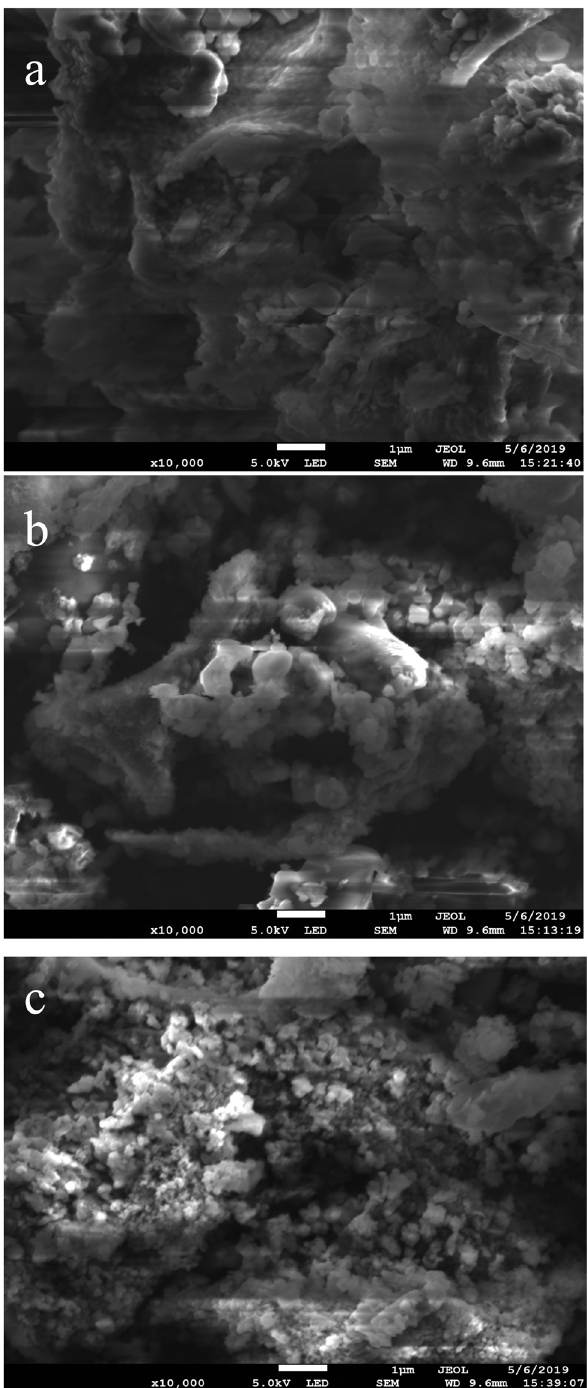
Figure 1: SEM image of di ff erent hydrochar: ( a ) H220, ( b ) H220 - U30, and ( c ) H220 - Ca15.